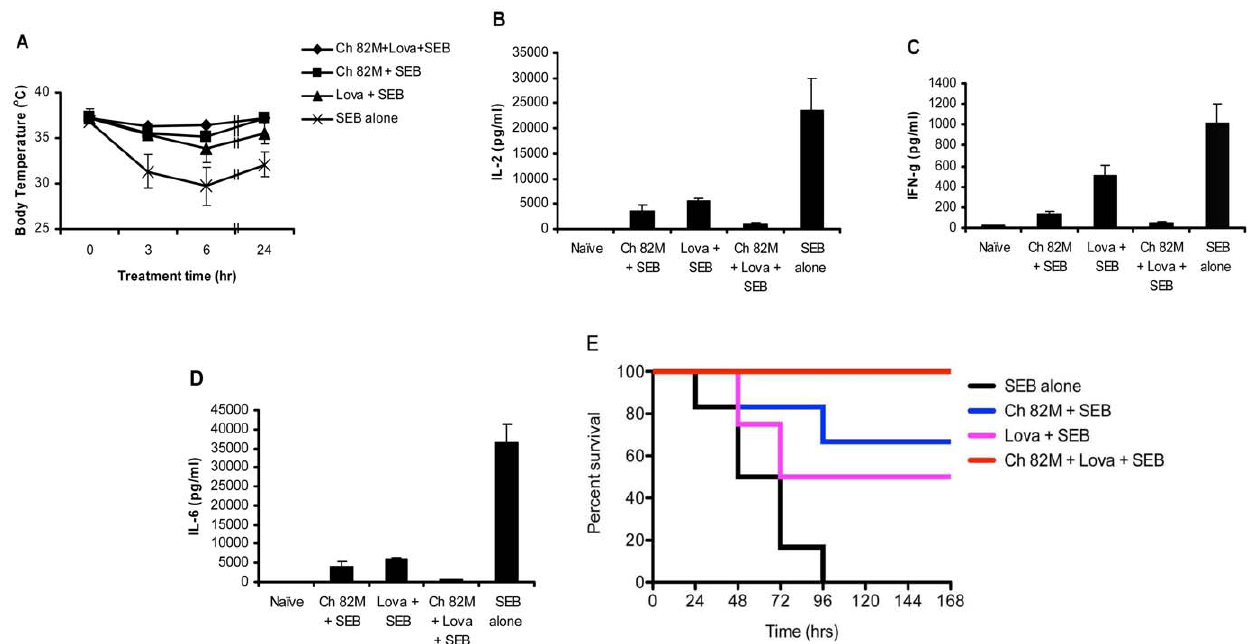
Figure 4. Chimeric anti-SEB 82M and lovastain provide invivo protection against SEB toxicity in HLA-DR3 transgenic mice. ( A ) Inhibition of SEB-mediated hypothermic effect. Age-matched HLA-DR3 transgenic mice were injected with the following: Ch 82 M + Lova + SEB ( ¤ ), 1 mg chimeric 82 M + 1 mg lovastatin + 50 m g SEB; Ch 82 M + SEB ( & ), 1 mg chimeric 82 M + 50 m g SEB; Lova + SEB ( m ), 1 mg lovastatin + 50 m g SEB; SEB alone ( 6 ), 50 m g SEB in PBS. Rectal temperatures were recorded at the indicated time points. Error bars are the means 6 s.d. for each group, and